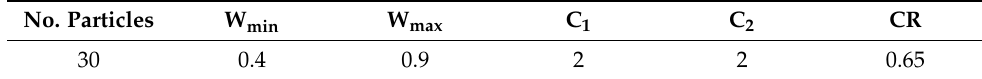
Table 5. The PSO parameters.